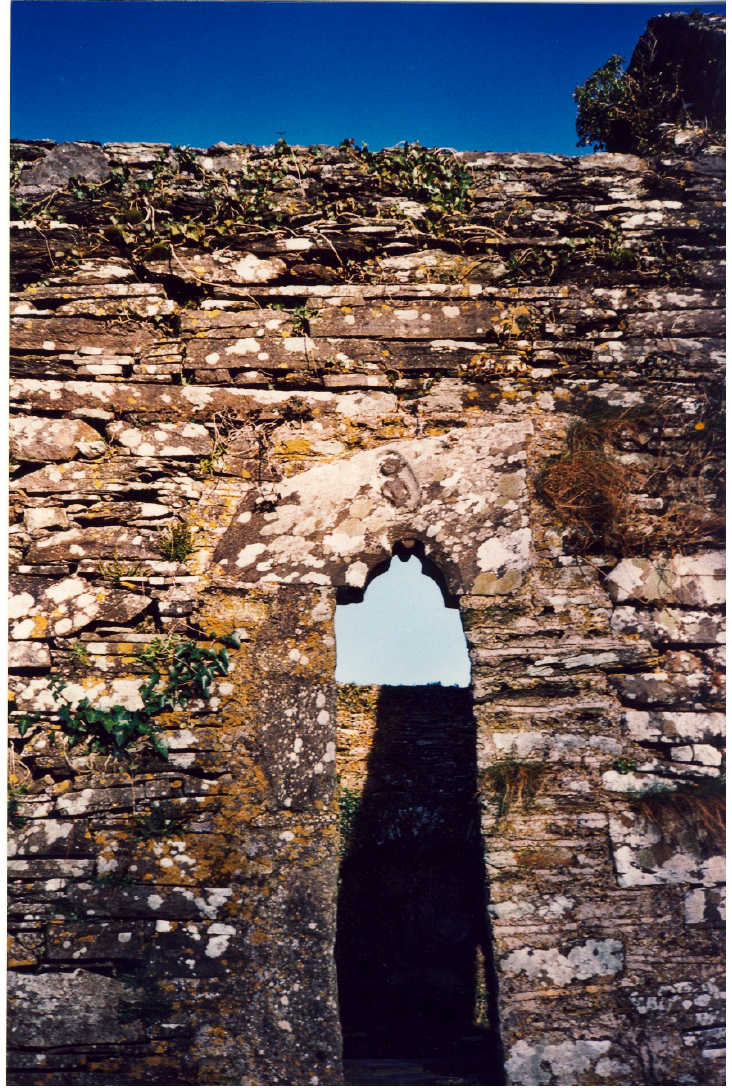
Figure 15. Sheela-na-gig , Ballyvourney.